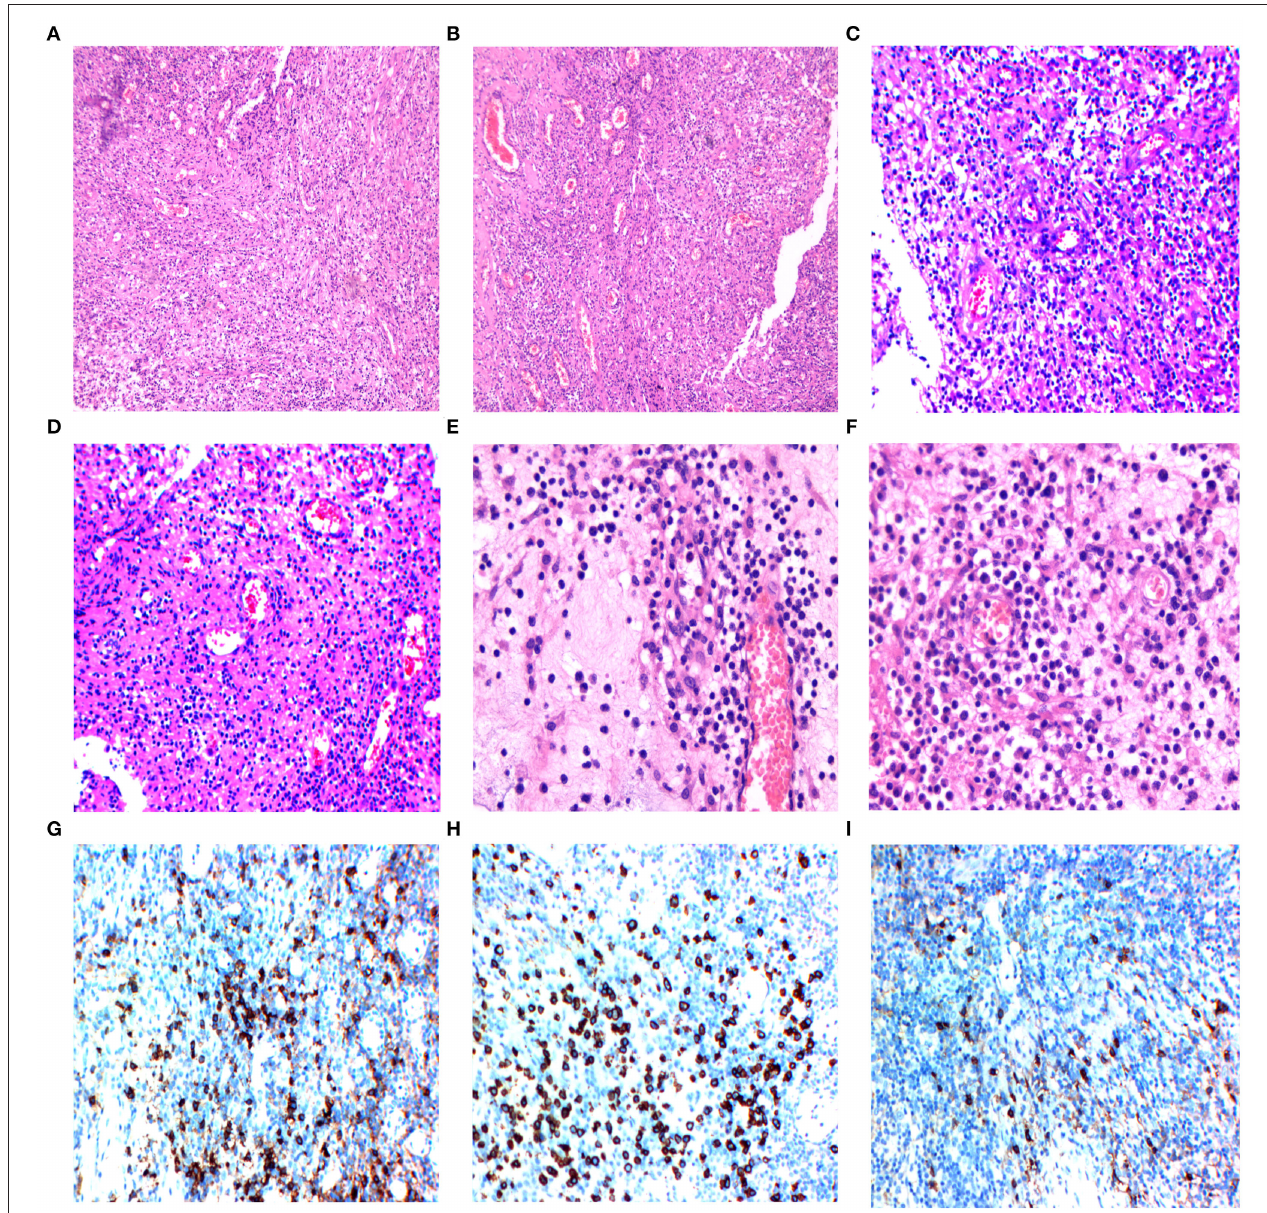
FIGURE 3 | (A,B) The histology of the intramedullary lesion showed chronic inflammatory lymphoplasmacytic infiltrate with fibrosis, 10 × 10 magnified view showed inflammatory cell collections (Hematoxylin-eosin, magnification 100 × ). (C,D) 20 × 10 magnified view demonstrated chronic inflammatory infiltration (hematoxylin-eosin, magnification 200 × ). (E,F) 40 × 10 magnified view showed rich lymphoplasmacytic infiltrates (plasma cells, eosinophils, macrophages, and lymphocytes) with storiform arrangement of spindle cells and dense fibrosis. (G) Immunohistochemistry with plasma cells (CD38 + ) in the infiltration area. (H) Immunohistochemistry with plasma cells (CD138 + ) in the infiltration area. (I) The IgG4 + cells account for more than 50% of the plasma